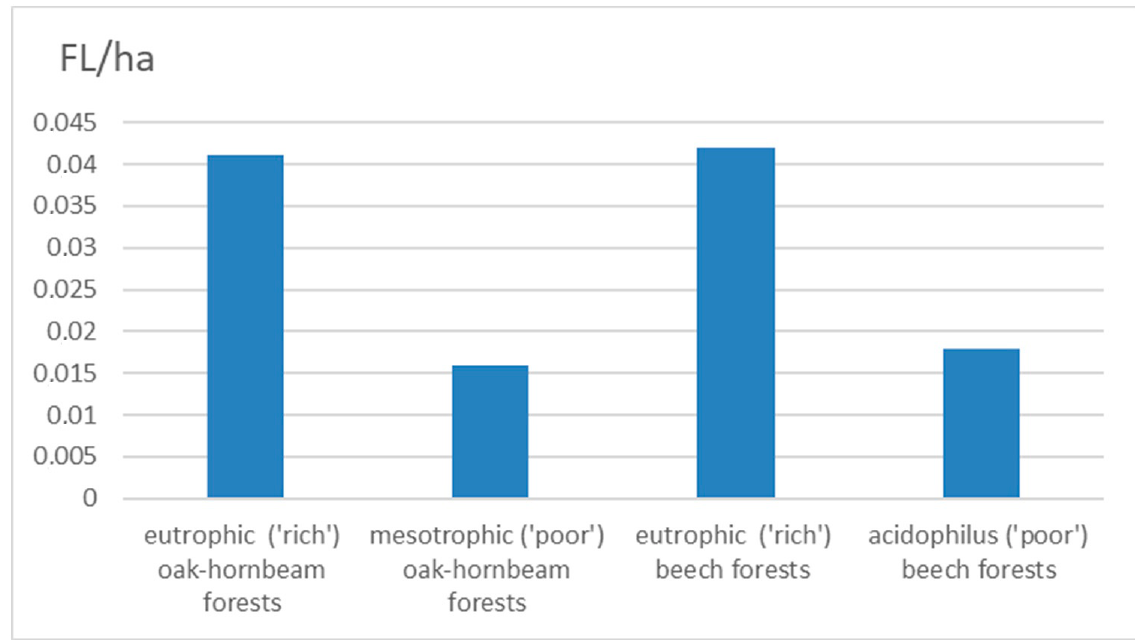
Figure 3. Comparison of the percentage distributions of the surface area (S) most important groups of potential natural vegetation (in the area covered by the study) and the percentage distributions of the fir localities numbers broken down into a different share in the stand (N).